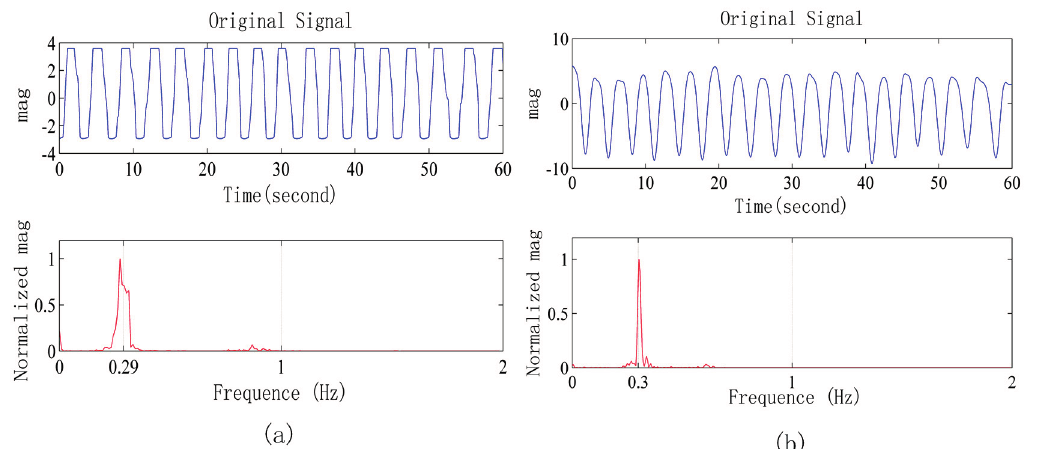
Figure 7. ( a ) Respiration waveforms obtained from the radar and its frequency spectrum; ( b ) Respiration waveforms obtained from the respiratory belt and its frequency spectrum.